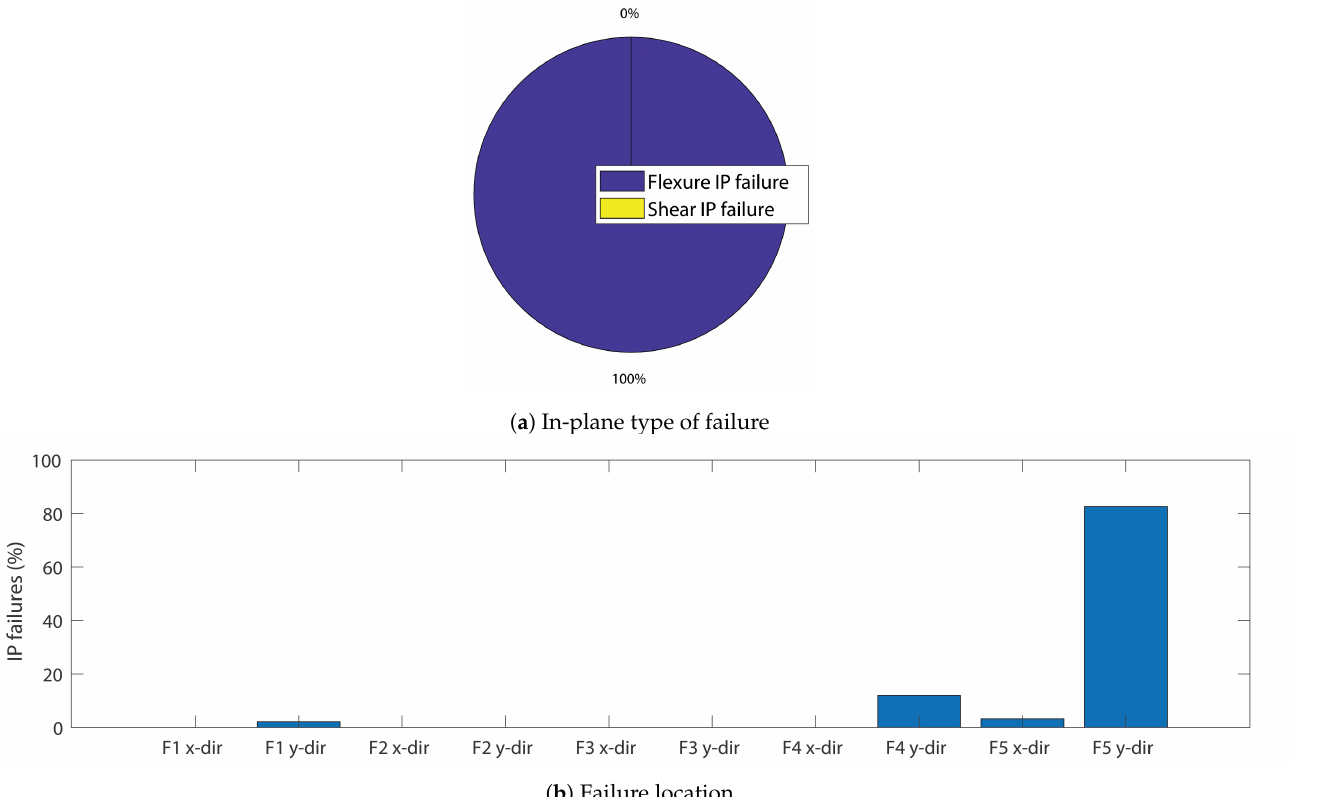
Figure 23. Lausanne Malley model (with out-of-plane disabled and rigid connections) failure statistics: ( a ) In-plane type of failure. ( b ) Failure